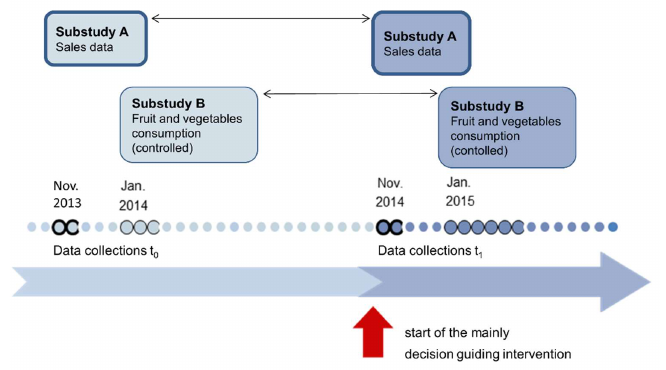
Figure 1. Study design.